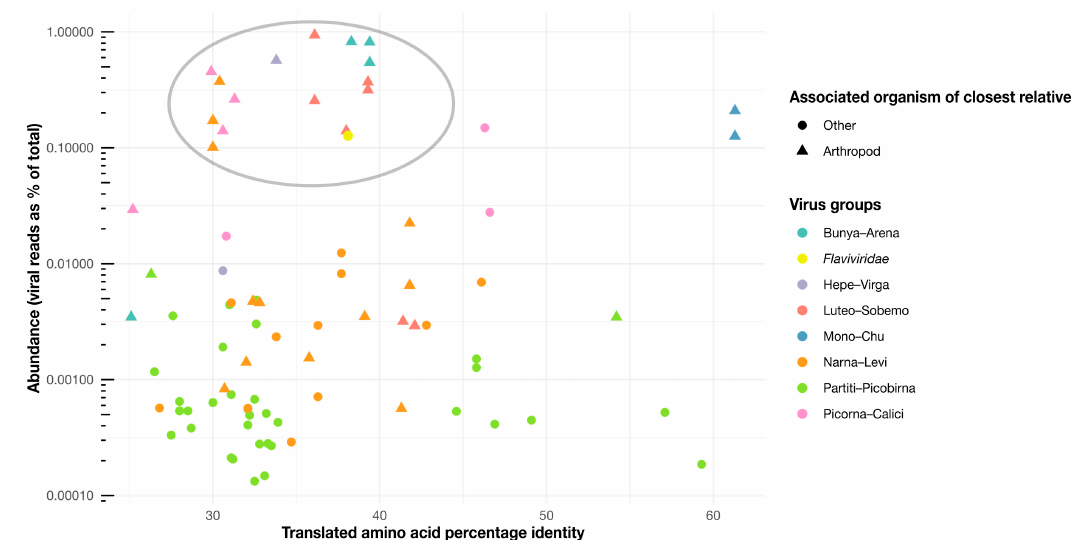
Figure 8. Abundance scatterplot for the novel viruses identified here. Each virus is represented by a single point, with the color indicating the taxonomic group the virus belongs to and the shape indicating the host organism of the closest virus relative (arthropod hosts are shown as triangles). The y-axis depicts the log abundance of the viruses, while the x-axis shows the translated amino acid percentage identity for each virus from their closest relatives. The gray circle indicates a cluster of viruses in relatively high abundance (generalized linear model, df = 81, p = 2 × 10 − 16 ) and closest relatives that commonly have arthropod associations (Pearson’s Chi-sq, df = 81, p = 4.6 × 10 − 6 ).